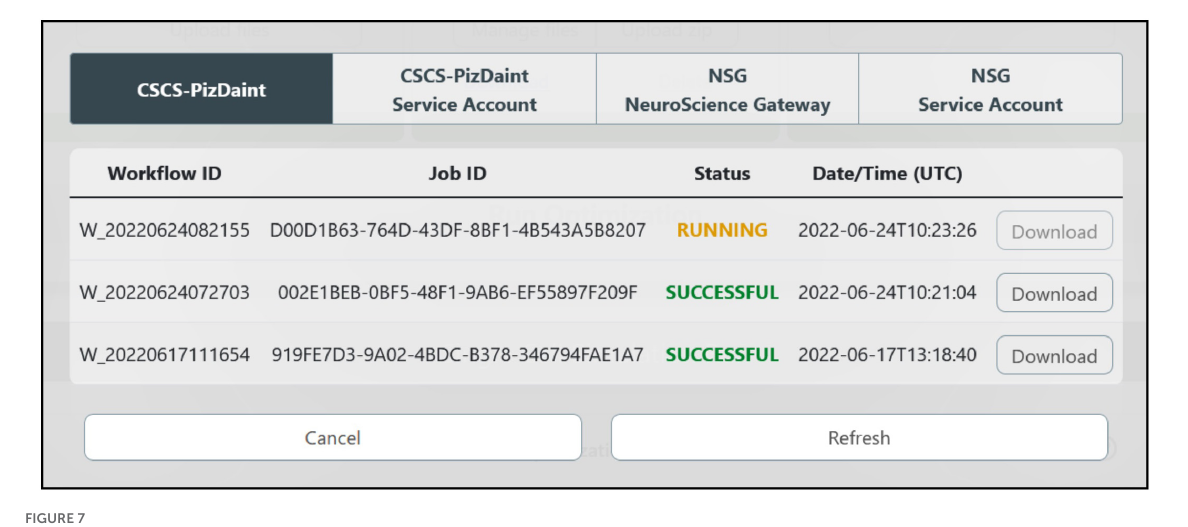
FIGURE7 HPC job result fetching. A dedicated window allows the users to check the status of the submitted jobs, grouped by HPC systems, and download them for model analysis and